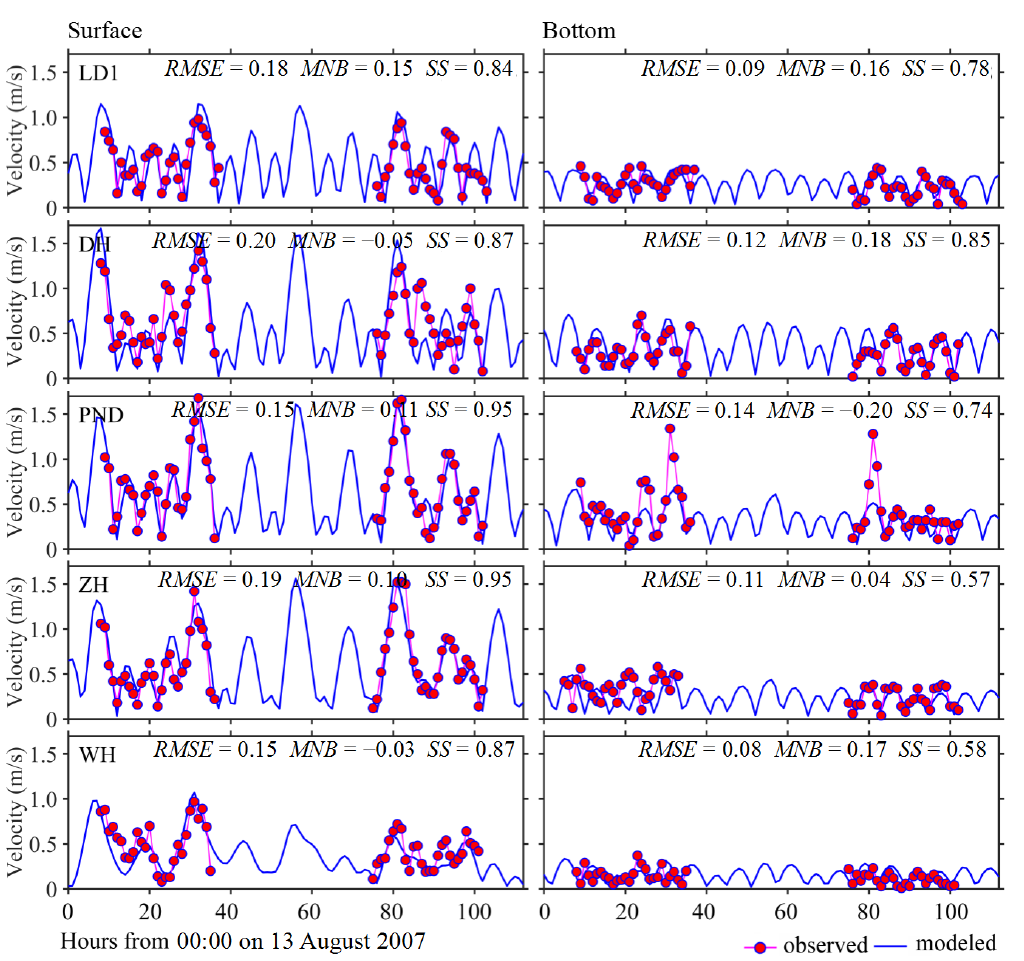
Figure 5. Comparisons of surface and bottom flow velocities. The locations of the stations LD1, DH, PND, ZH and WH are shown in Figure 2 by black dots. PND, ZH and WH are shown in Figure 2 by black